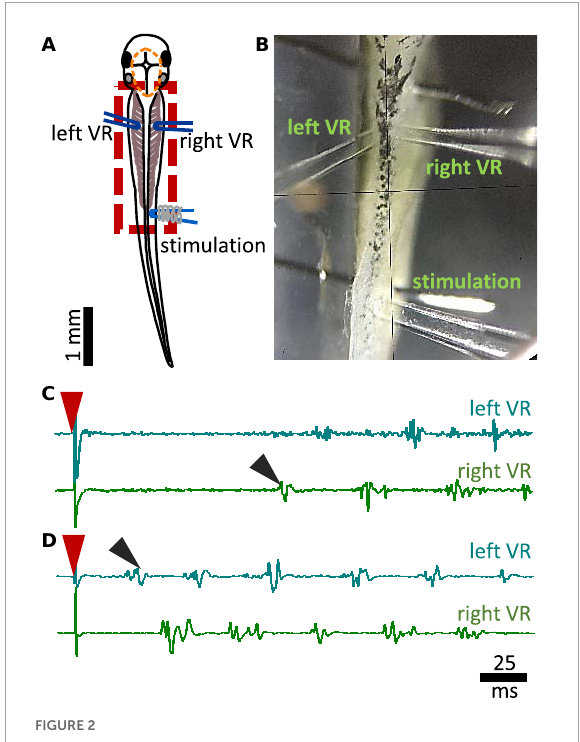
FIGURE2 Experimental setup for fictive swimming. (A) Dorsal view of the tadpole with recording and stimulating electrodes in position. Left and right VR (ventral root) electrodes were positioned facing each other approximately at the 4th myotomal cleft. The stimulating electrode was always positioned on the right side at the level of the anus. Red dashed line denotes the area of open skin with the brain visible. Red dashed square area indicates the area presented in panel (B) . (B) Picture of the trunk of a tadpole pinned to the Sylgard block during extracellular VR recordings. Right and left VR and stimulating electrodes, are positioned as described in A. (C) Example of an ipsilateral start of fictive swimming in response to electrical trunk skin stimulation (red arrowhead). The first VR burst is recorded on the right side of the body (right VR, ipsilateral; black arrowhead). (D) Example of a contralateral start of fictive swimming in response to electrical trunk skin stimulation (red arrowhead). The first VR burst is recorded on the left side of the body (contralateral, left VR; black arrowhead). In all experiments stimulation was delivered on the right side of the tadpole’s